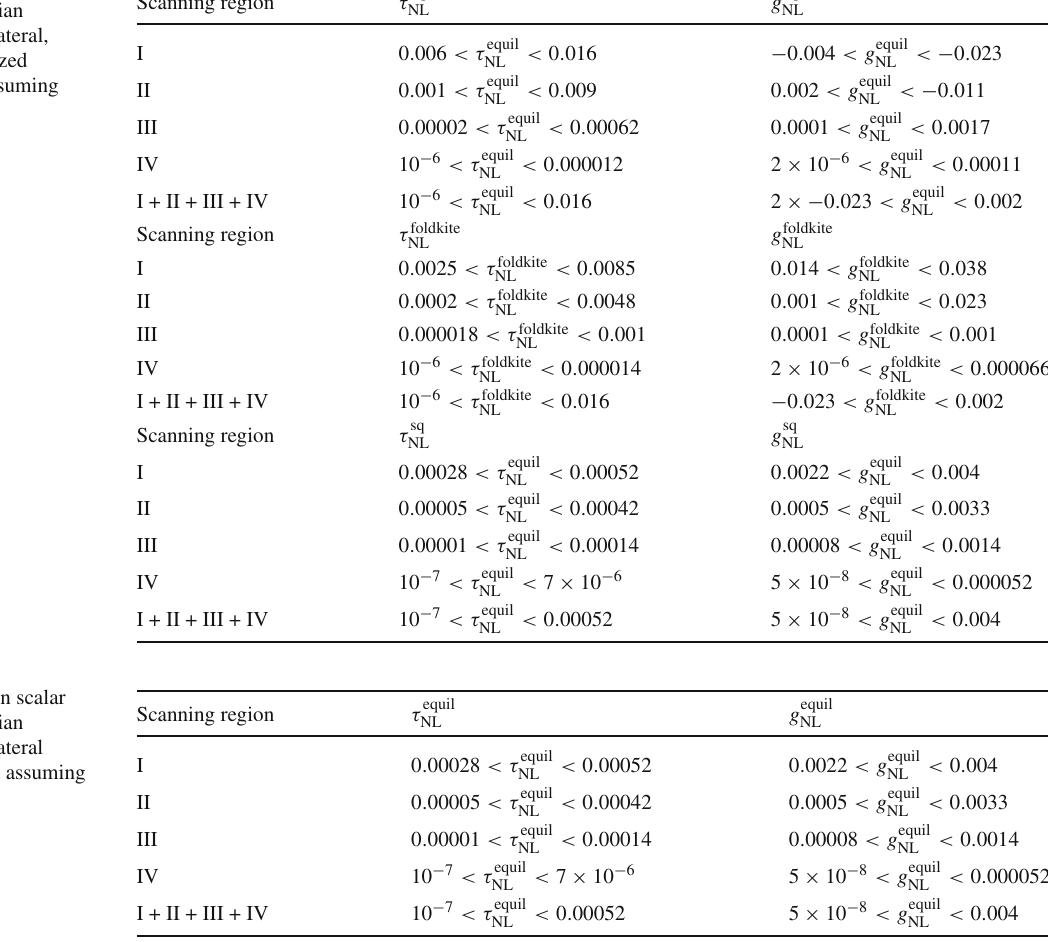
four point non-Gaussian amplitude from equilateral, folded kite and squeezed configuration with assuming Suyama–Yamaguchi consistency relation